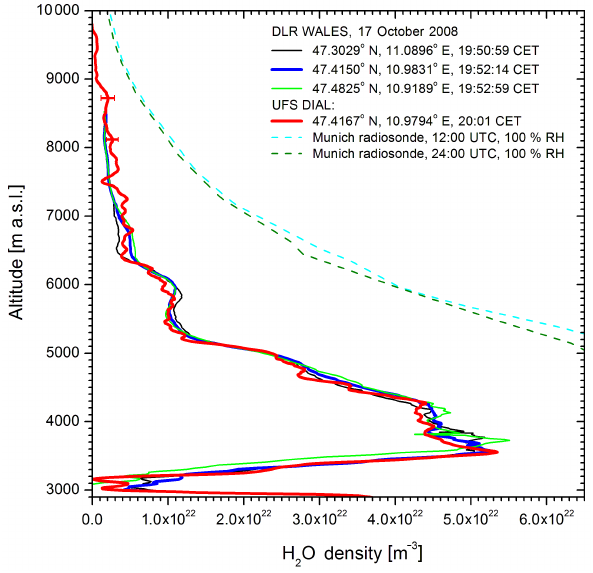
Figure A3. Comparison of Zugspitze (UFS) DIAL and WALES; three WALES density profiles are shown around the time of the overflight. The best agreement was found for the best matching of the co-ordinates. The UFS data were smoothed less than in Fig. 10. The density profiles for 100% RH is given in dashed lines (Munich, 01:00 and